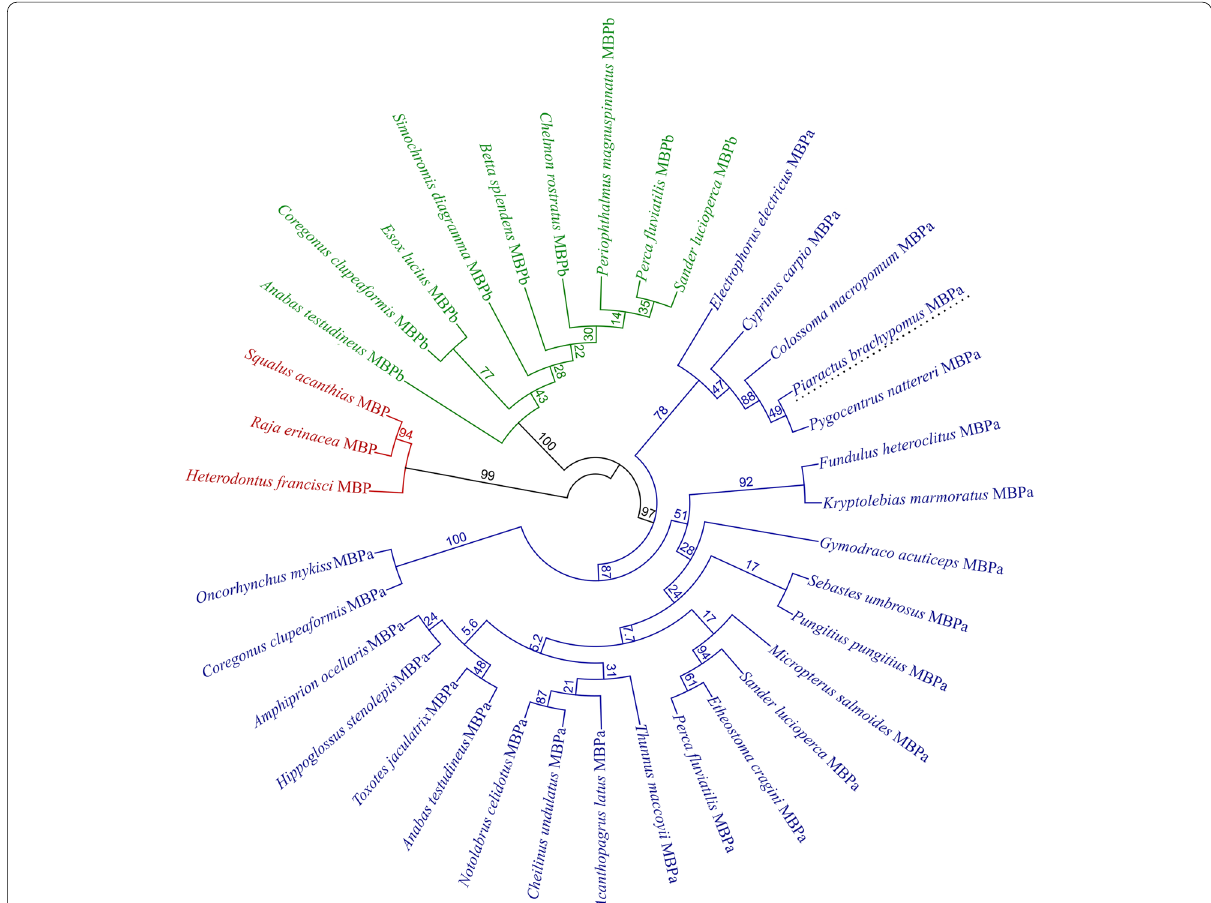
Fig. 2 Phylogenetic tree of MBP from teleost and cartilaginous fish made by the neighbor‑joining method. Red clade: MBP; green clade: MBPb; blue clade: MBPa. Piaractus brachypomus is noted in the dotted underline terminal taxon. Tree is composed of 36 amino acid sequences of MBP, MBPa, and MBPb translated from mRNA sequences retrieved from GenBank. Alignment was generated using ClustalW in Geneious Prime software